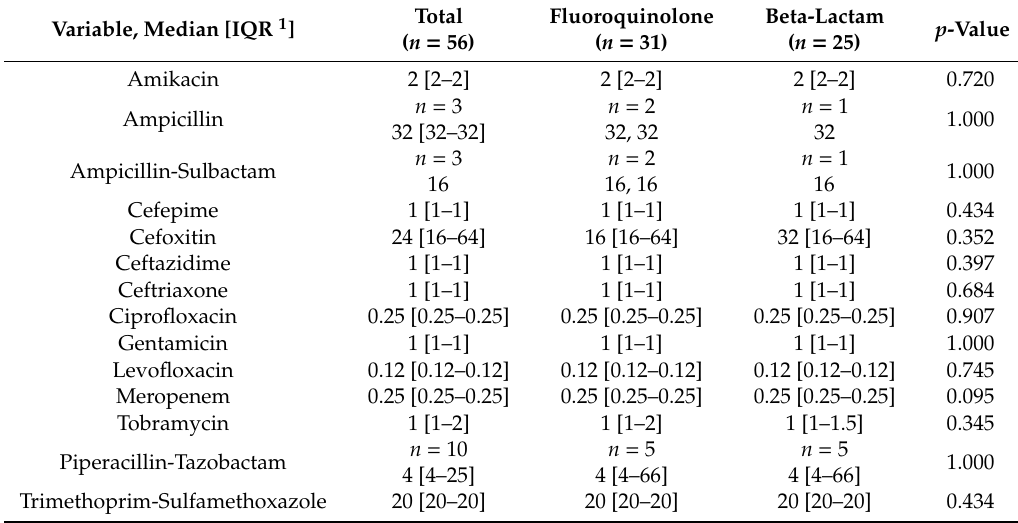
Table 3. Minimum Inhibitory Concentrations ( µ g / mL) in CAE Bloodstream Infections.